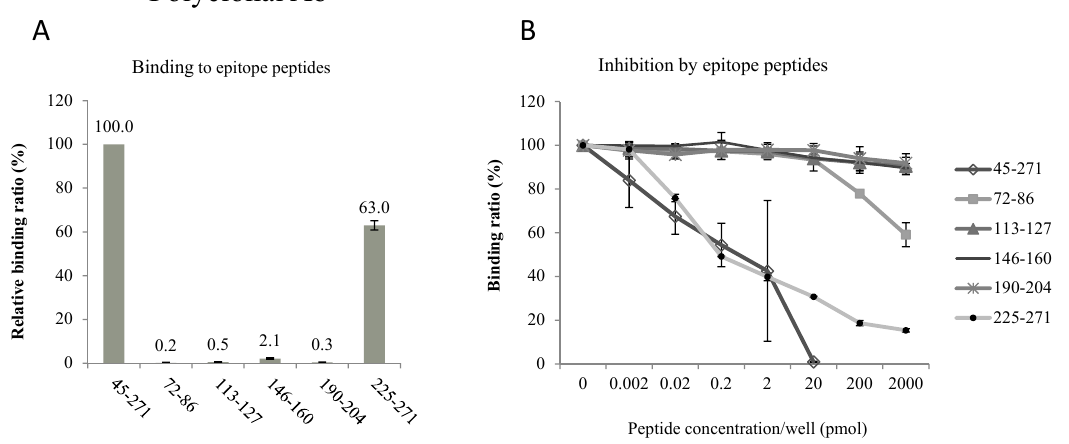
Figure 4. Determination of epitopes of the polyclonal antibody. Five synthetic peptides were used for binding assay ( A ) and competitive inhibition assay ( B